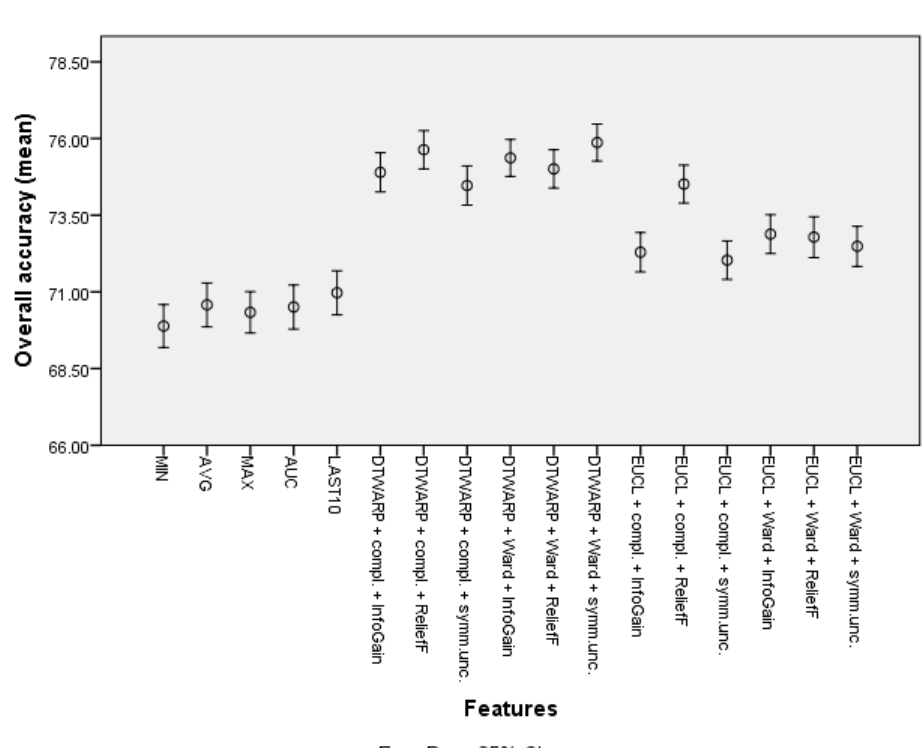
13 of 18 Table 2. Classification results using Random Forests. Feature